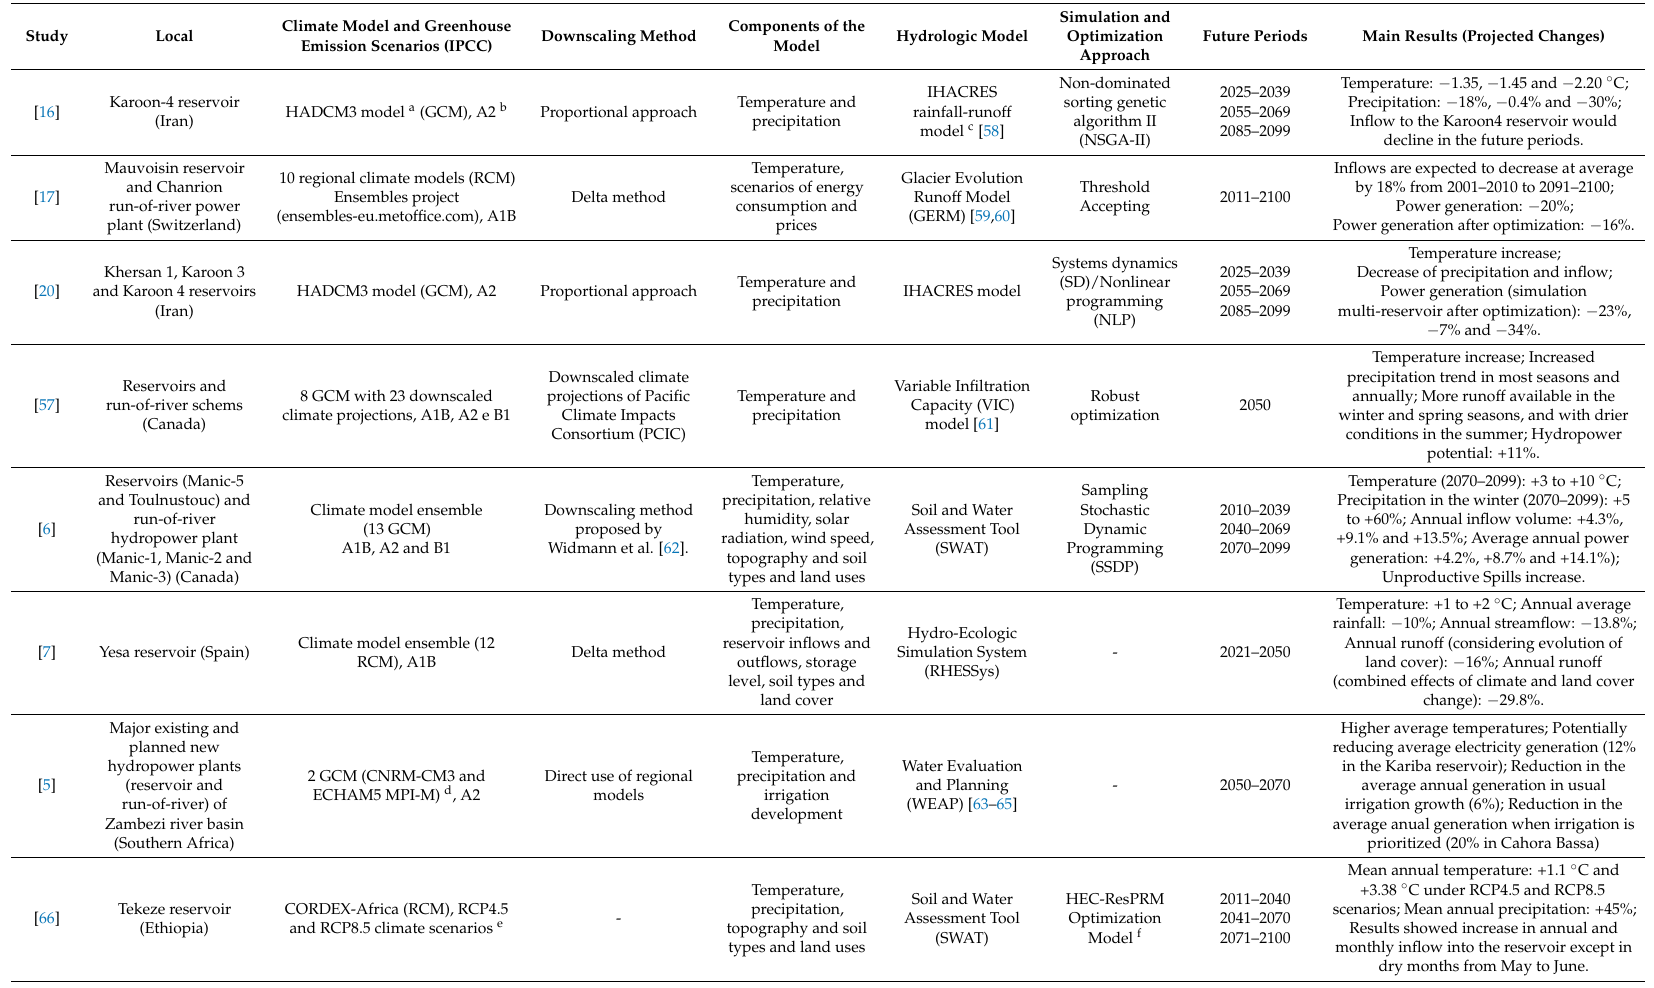
Table 3. Methodologies and main results of studies on impacts of climate change on reservoir